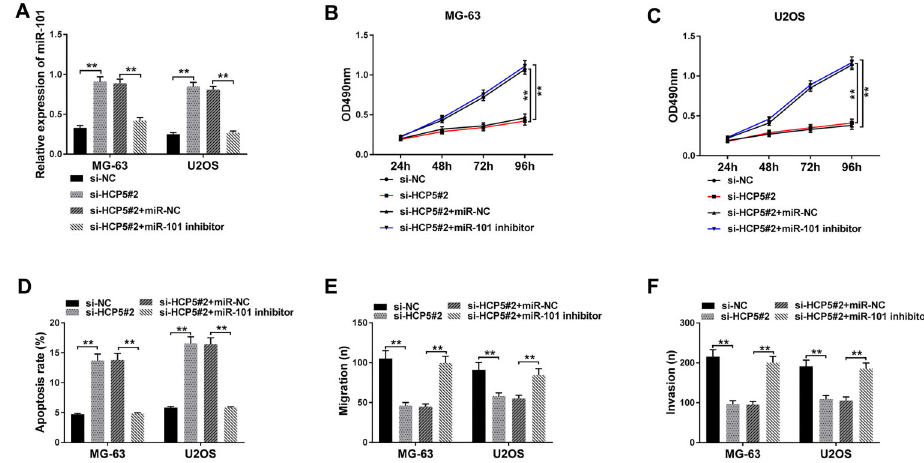
Figure 4. Depletion of miR-101 could reverse the impact on cell proliferation, apoptosis, migration, and invasion caused by HCP5 knockdown in osteosarcoma (OS) cells. A , The expression of miR-101 in MG-63 and U2OS cells transfected with si-NC (negative control), si-HCP5#2, si-HCP5#2 + miR-NC, or si-HCP5#2 + miR-101 inhibitor was measured by qRT-PCR. B and C , Cell proliferation was assessed at 24, 48, 72, and 96 h after transfection by MTTassay in MG-63 and U2OS cells. D , Cell apoptosis was analyzed by fl ow cytometry. E and F , Transwell assay was used for cell migration and invasion analysis in MG-63 and U2OS cells. Data are reported as means ± SD. ** P o 0.01 (Student ’ s t -test and